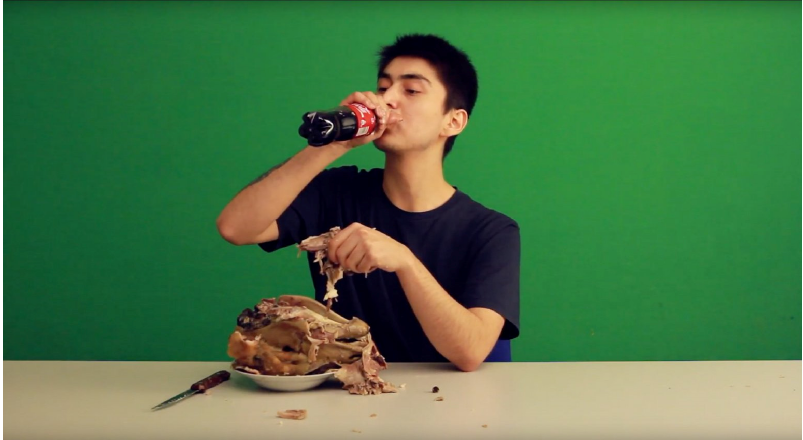
Figure 5. Anvar Musrepov, still video Eating Ram’s Head (2017). Image courtesy of the artist. At the same time, Eating Ram’s Head (2017) draws on Warhol’s obsession